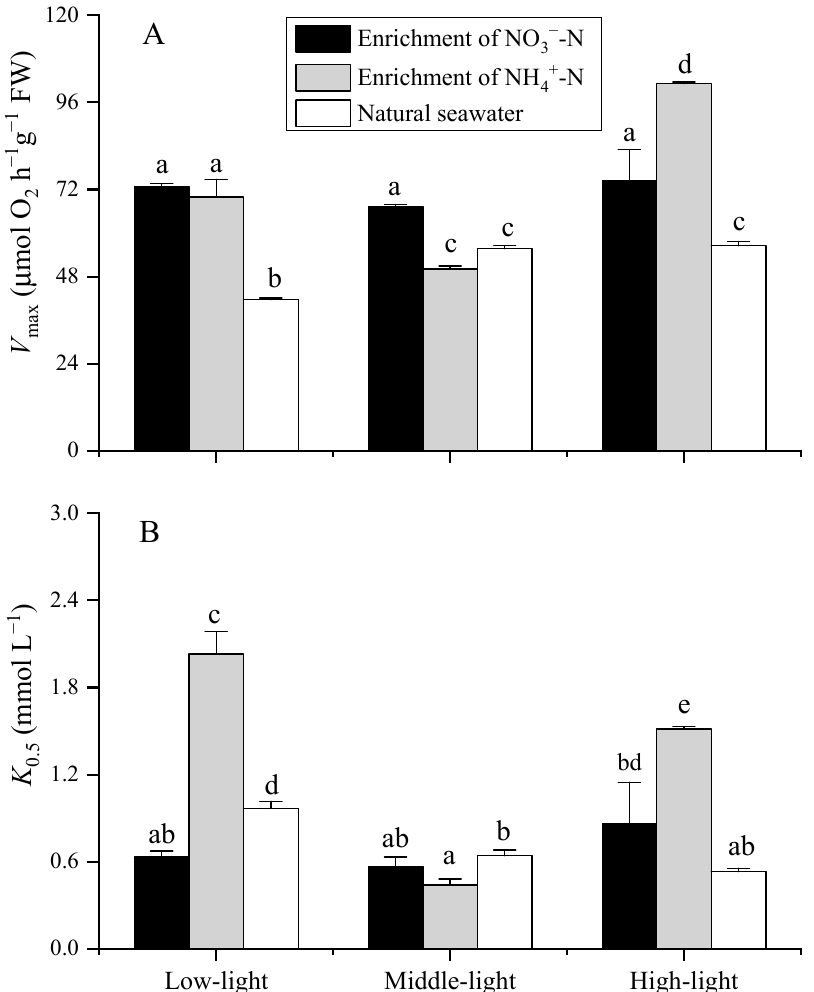
Figure 3. The carbon-saturating maximum photosynthetic rate ( V max , A ) and half saturation constant ( K 0.5 , B ) for S. horneri cultured under different light and N conditions for 10 days. Data are reported as means ± SD (n = 3). Different letters above the error bars indicate significant differences between treatments ( P < 0.05).